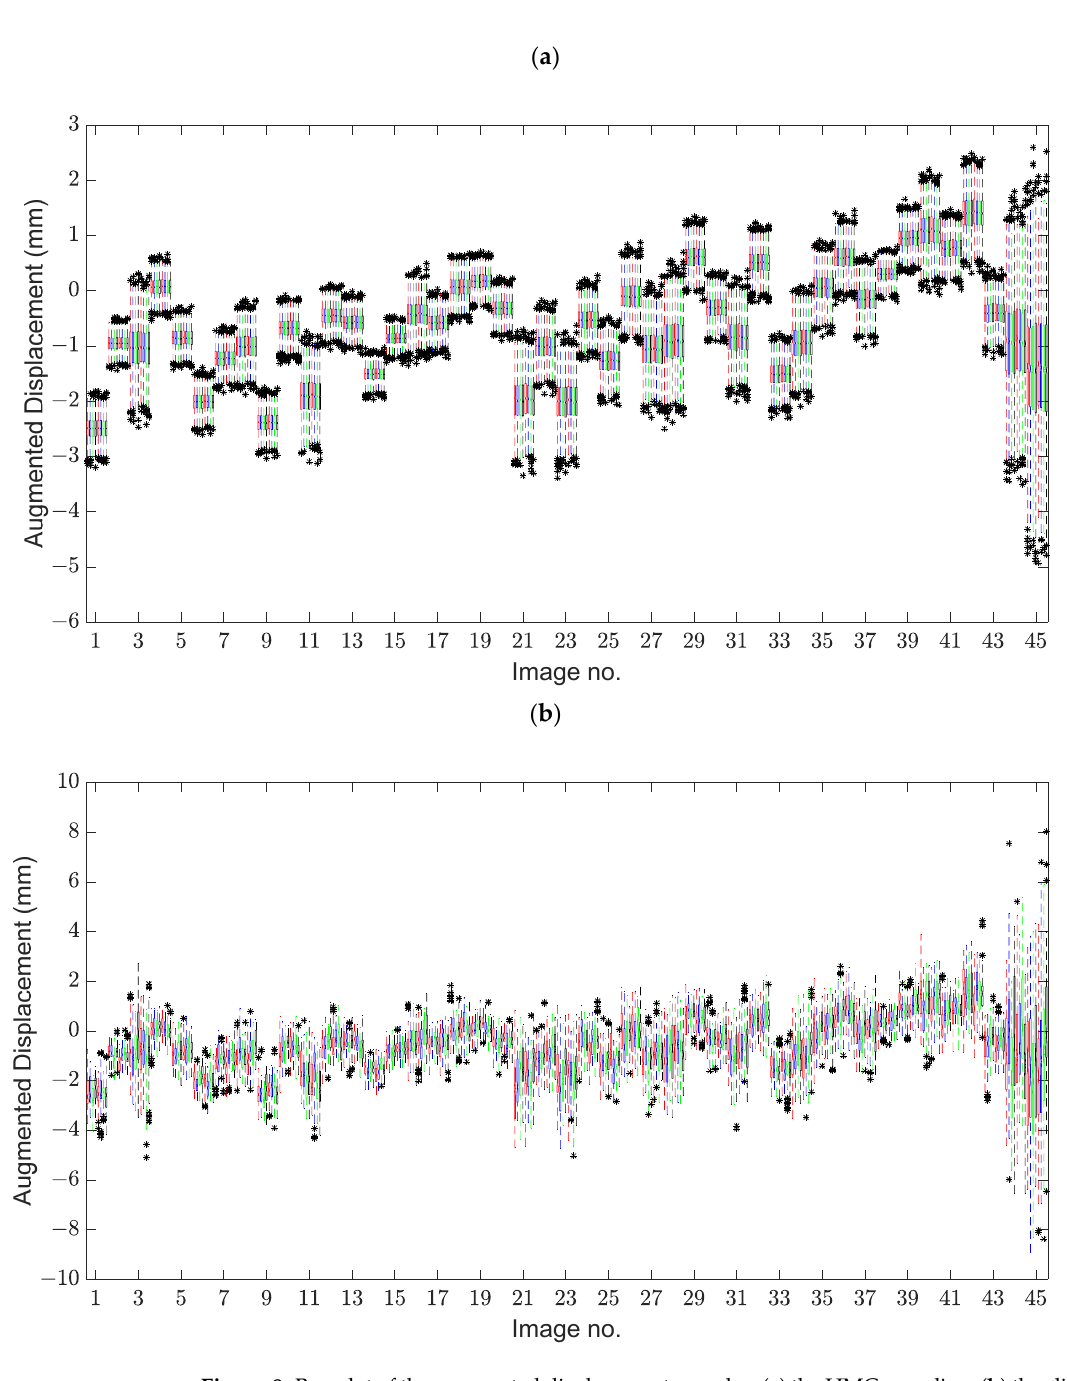
Figure 8. Box plot of the augmented displacement samples: ( a ) the HMC sampling, ( b ) the slice sampling.